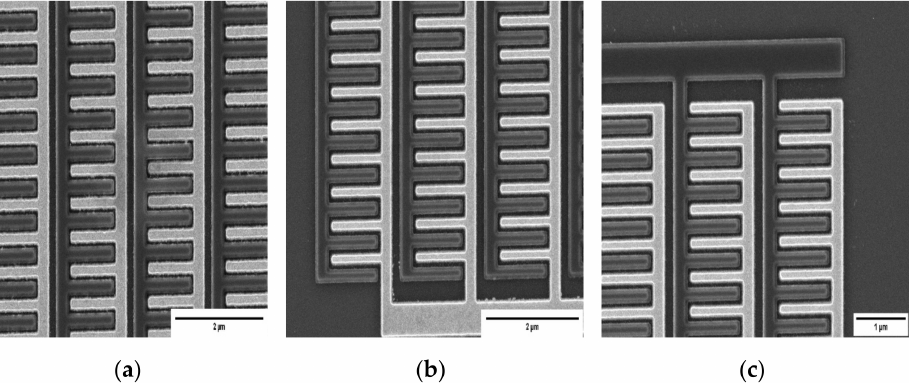
Figure 3. SEM images of the device after the second EBL ( a ) at the center; and ( b , c ) at the